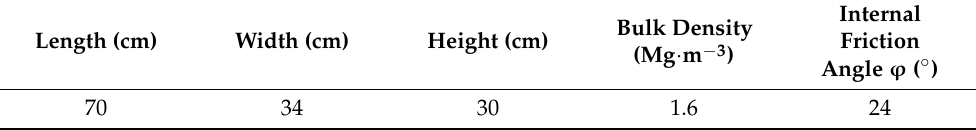
Table 1. Properties of the soil sliding body.